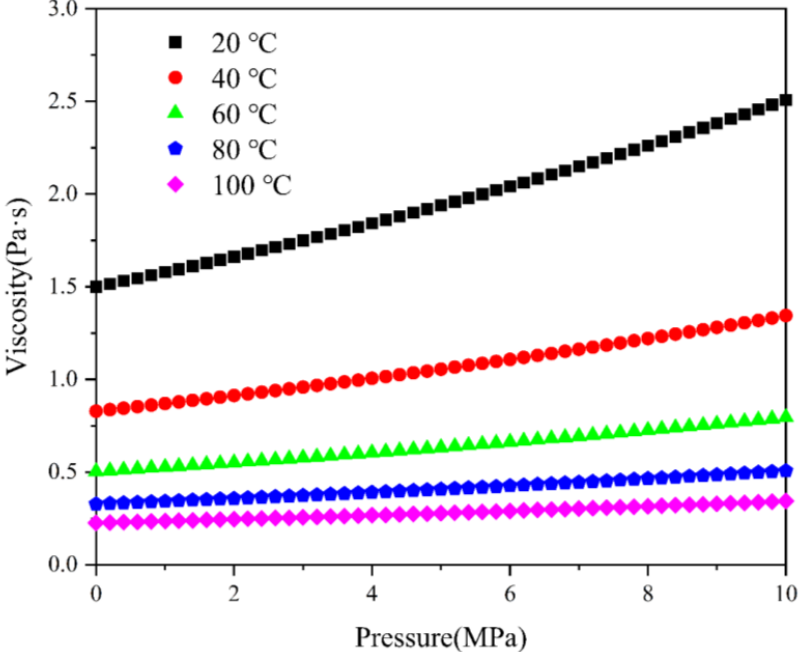
Figure 4. Magnetic fluid lubrication film viscosity relationship.